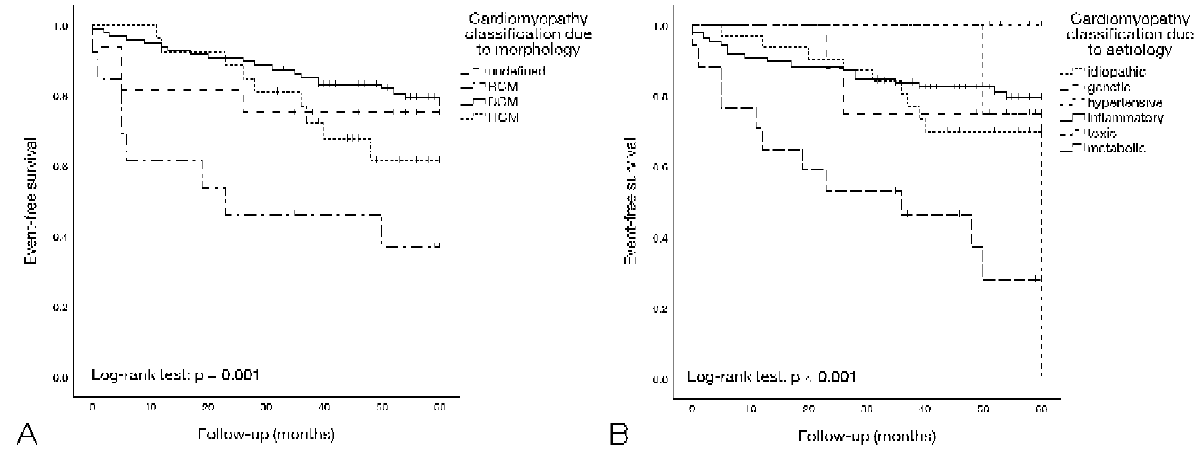
Figure 4: Kaplan-Meier survival analysis according to morphologic CMP classification (A) and CMP aetiologies (B). RCM (n = 13), DCM (n = 94), HCM (n = 26), undefined (n = 16); idiopathic CMP (n = 31), genetic CMP (n = 8), hypertensive CMP (n = 4), inflammatory CMP (n = 85), toxic CMP (n = 4), metabolic CMP (n =